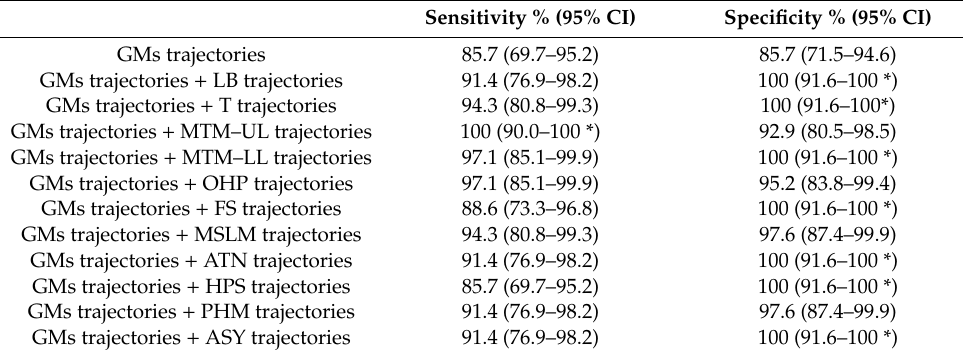
Table 8. Sensitivity and specificity if we consider GMs trajectories alone and in association with trajectories of concomitant motor and postural patterns.